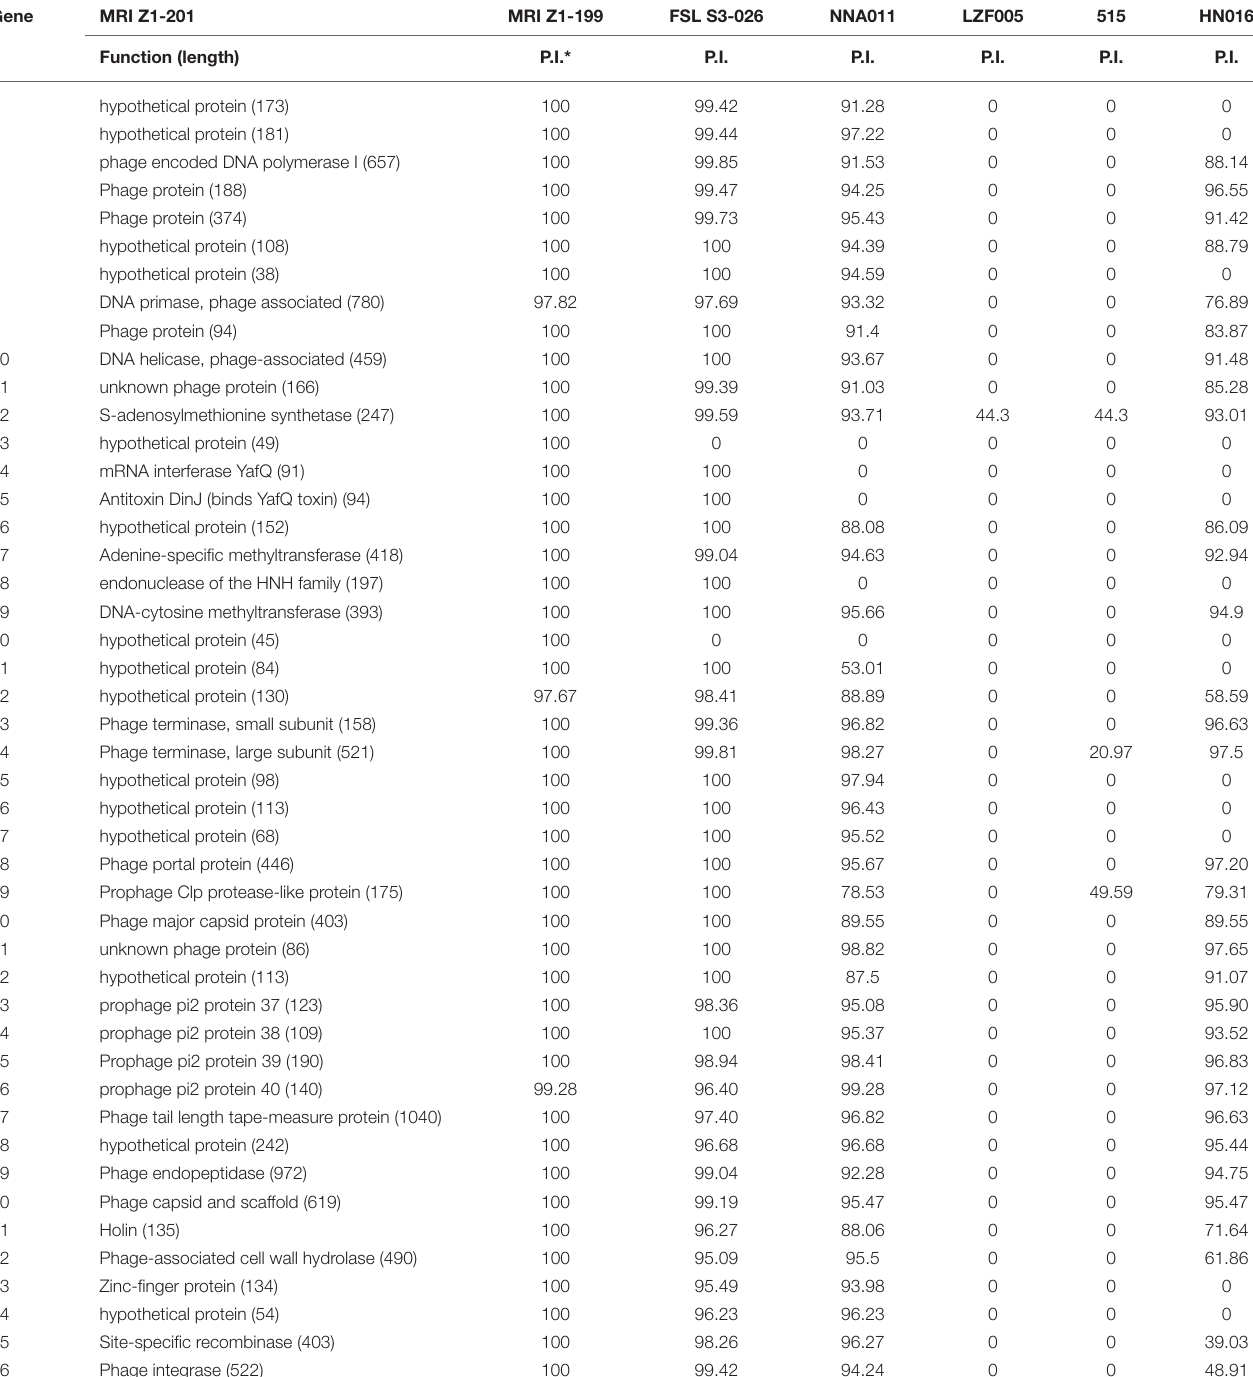
TABLE 2 | Gene function of P1 region and coding sequence alignment.